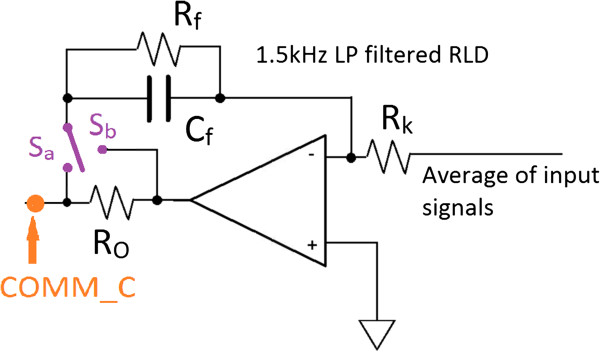
Right leg driver circuit. The cross section of the ear was adapted from [25] with permission.